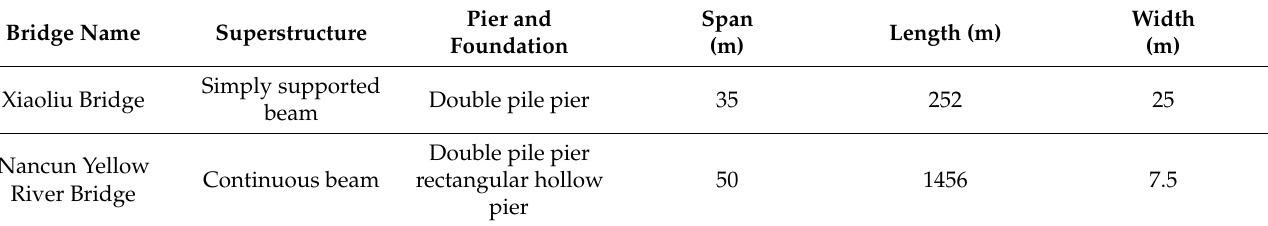
Table 1. Basic Information of Experimental Bridges.